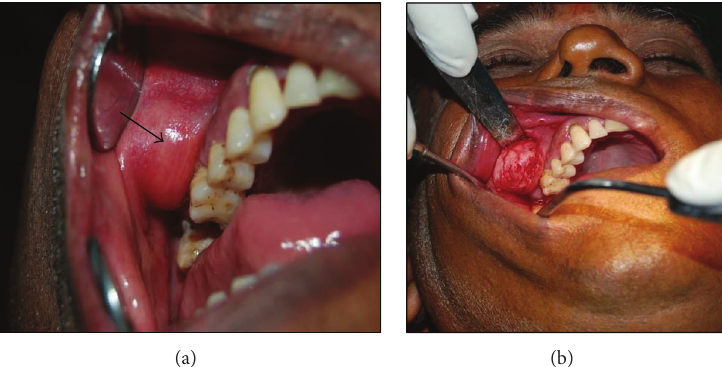
Figure 1: (a) Well circumscribed lesion in the alveolar mucosa. (b) Encapsulated tumour on surgical exploration.